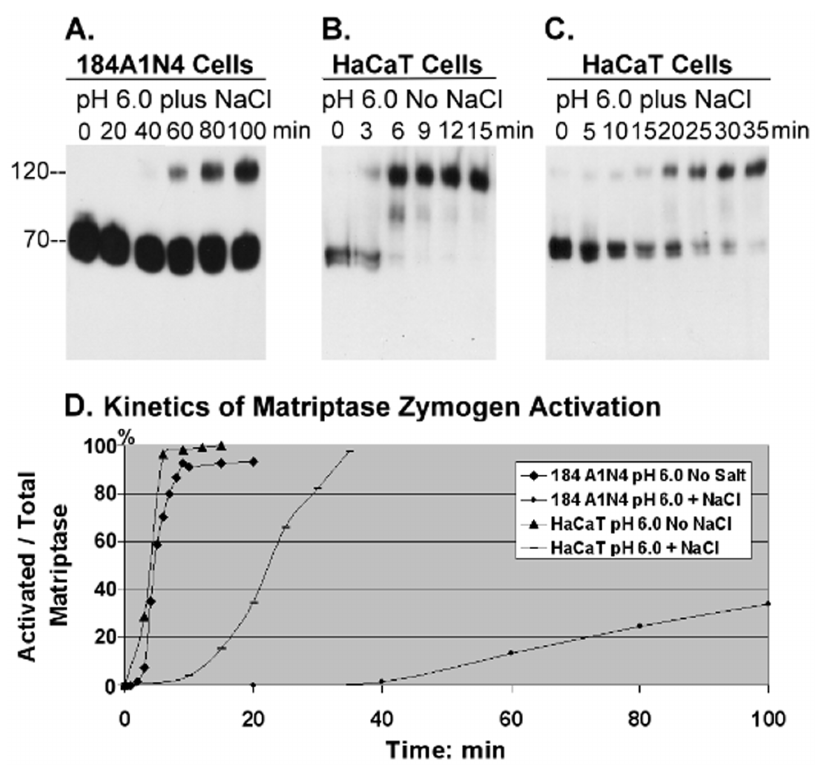
Figure 3. Impact of sodium chloride on matriptase activation. Living 184 A1N4 mammary epithelial cells (A) and HaCaT human keratinocytes (B, C) were exposed to phosphate buffer pH 6.0 at room temperature for the indicated times in the presence (A, C) or absence (B) of 150 mM NaCl. Cell lysates were prepared and assayed by immunoblot analyses for matriptase using mAb M24. Note that the corresponding data for 184 A1N4 mammary epithelial cells exposed to phosphate buffer pH 6.0 in the absence of NaCl is presented in Figure 2D. (D) The impact of NaCl on the kinetics of the induction of matriptase activation in living cells. The ratio of activated matriptase relative to total matriptase (activated plus zymogen matriptase) was plotted against time using Image J.